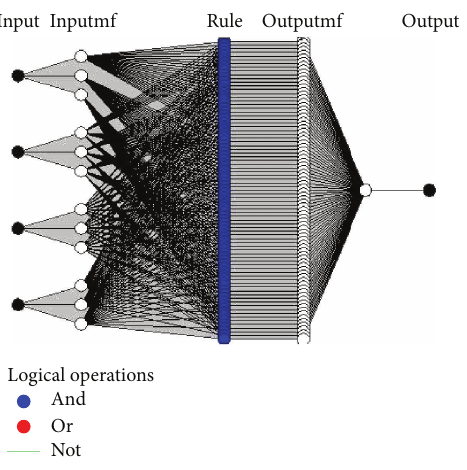
Figure 1: The structure of ANFIS model for steam distillation recovery estimation.